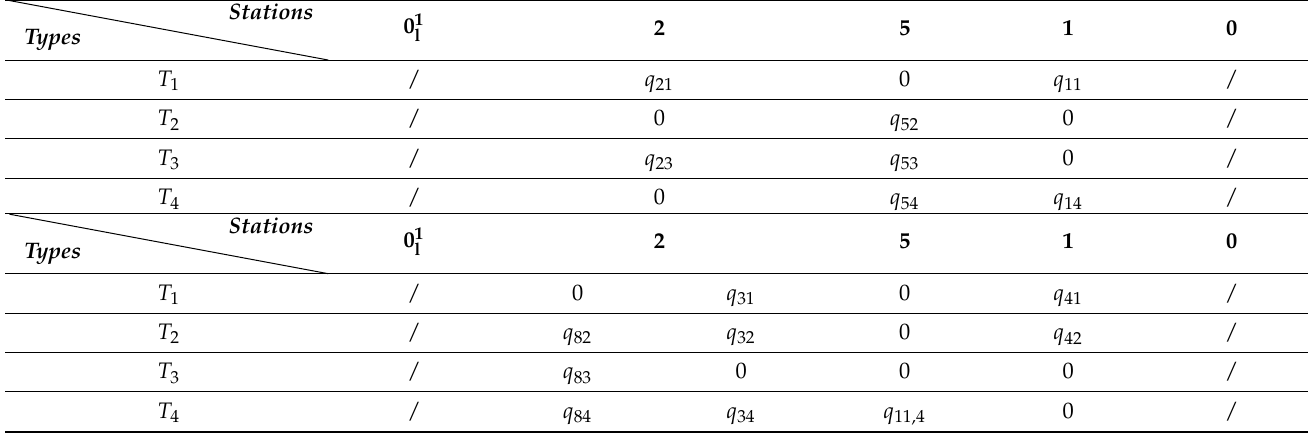
Table 3. Example of a solution of 3 vehicles with 11 stations and 4